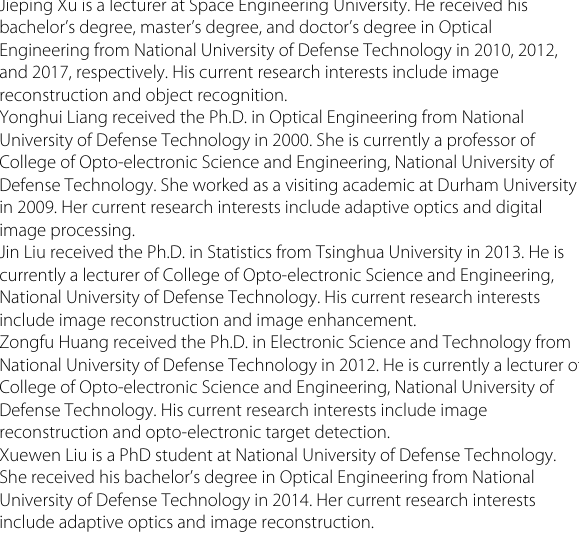
HR image, we chip crop an image of the same zone from Google Earth, which was captured on September 16, 2015. Figure 9 shows one bicubic-interpolated LR image, the final reconstructed HR image by OSR and MAP, and the image chipped cropped from Google